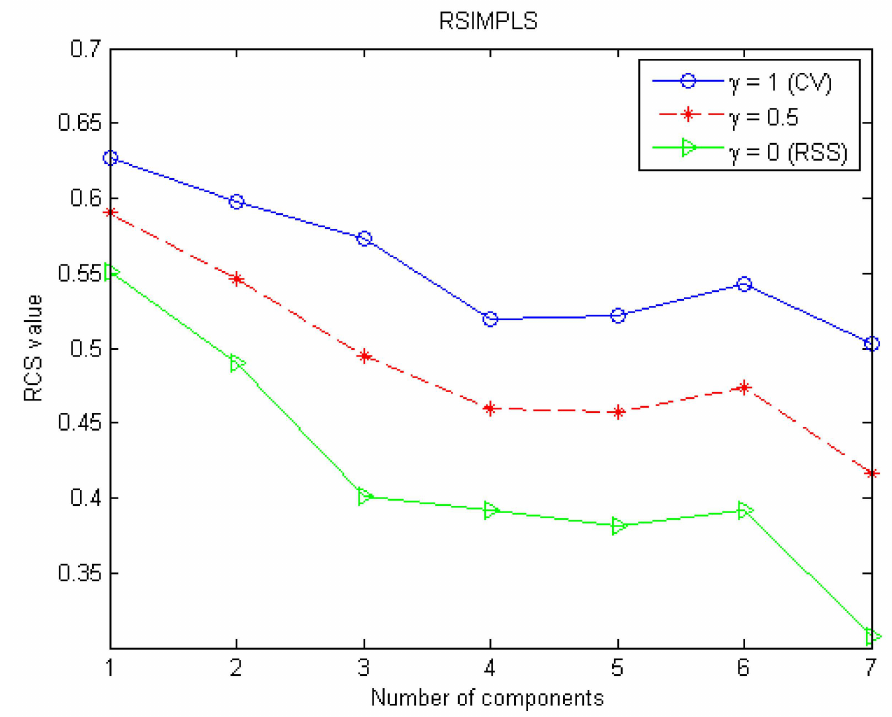
Figure 1. Optimization the number of latent variables